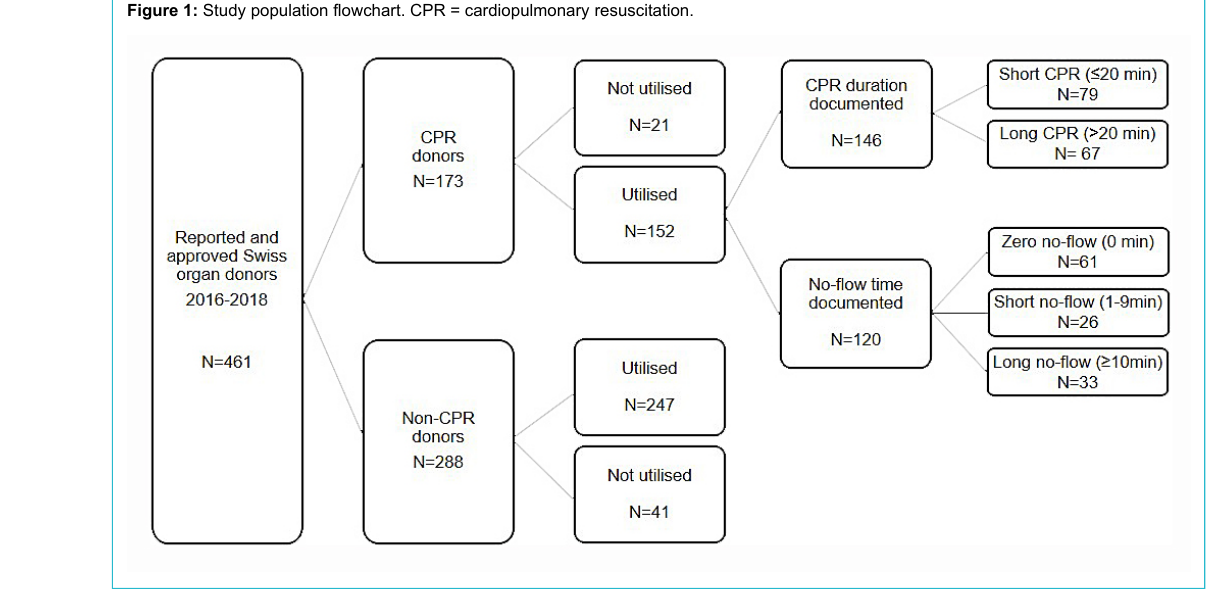
Figure 1: Study population flowchart. CPR = cardiopulmonary